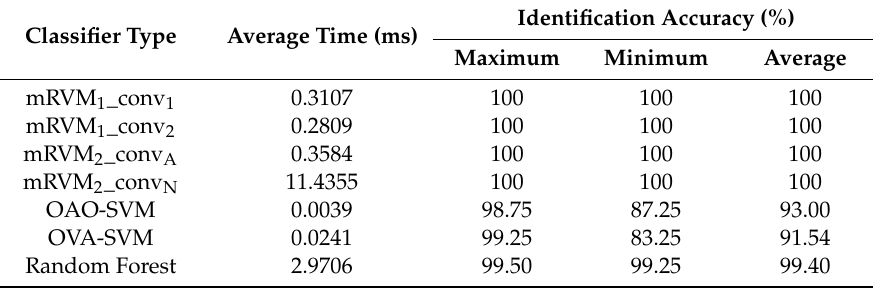
Table 9. Fault identification accuracy of di ff erent classifiers with the load 2 hp.